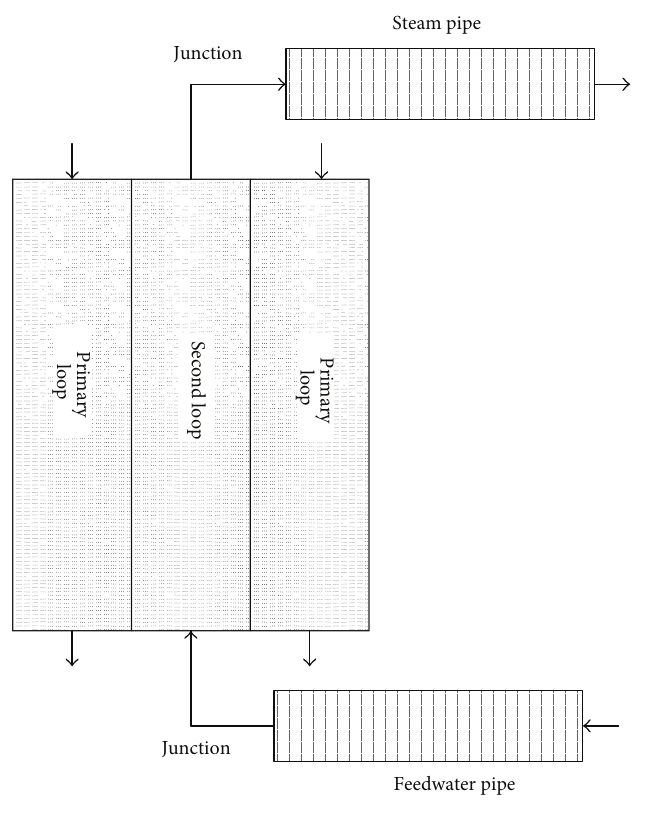
Figure 6: Node map of OTSG.